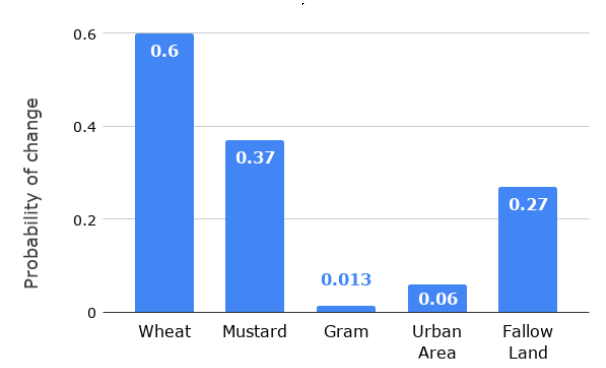
Figure 4: Probability of change for different